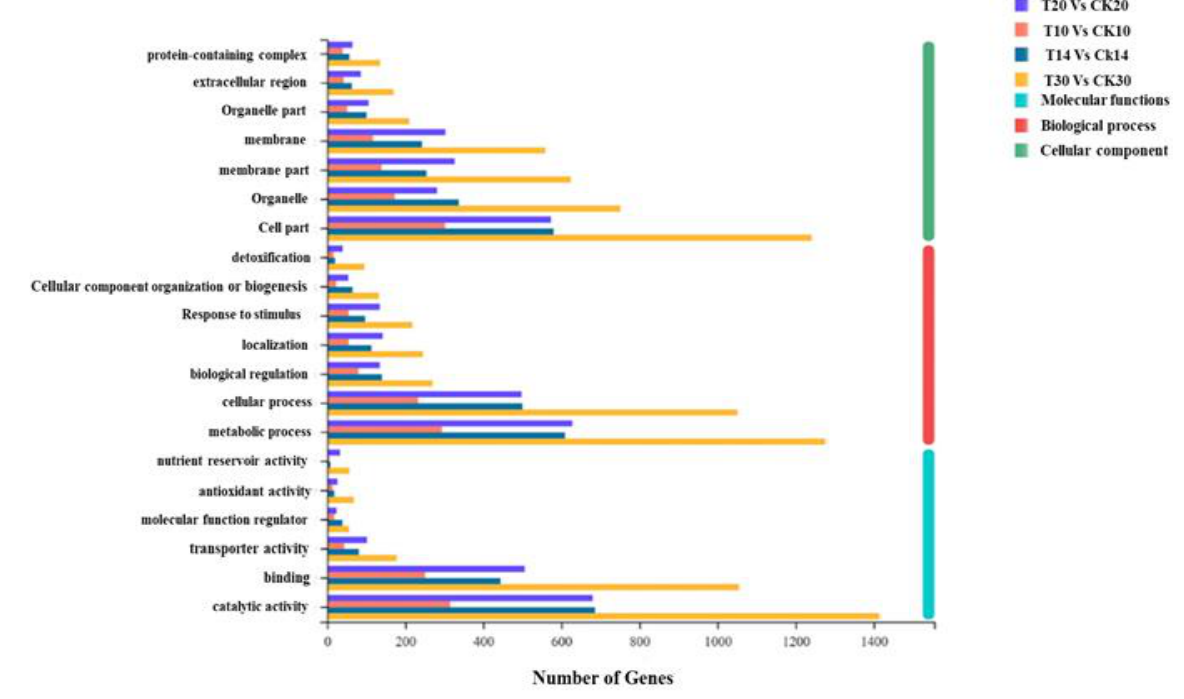
Figure 7. Histogram of Gene Ontology (GO) classifications of DEGs between T10 vs. CK10, T14 vs. CK14, T14 vs. CK14, T20 vs. CK20, and T30 vs. CK30. A total of 373, 378, 203, and 444 DEGs were assigned to three main GO functional categories and then divided into 20 sub-categories.